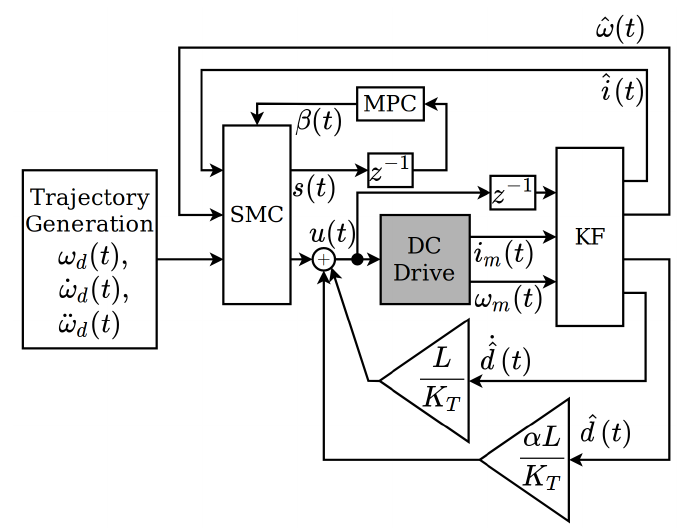
Figure 2. Implementation of the sliding mode control (SMC) in combination with a Kalman filter (KF) for state and parameter estimation and an model predictive control (MPC) for the adaptation of the switching height. The gray block represents the direct current (DC)